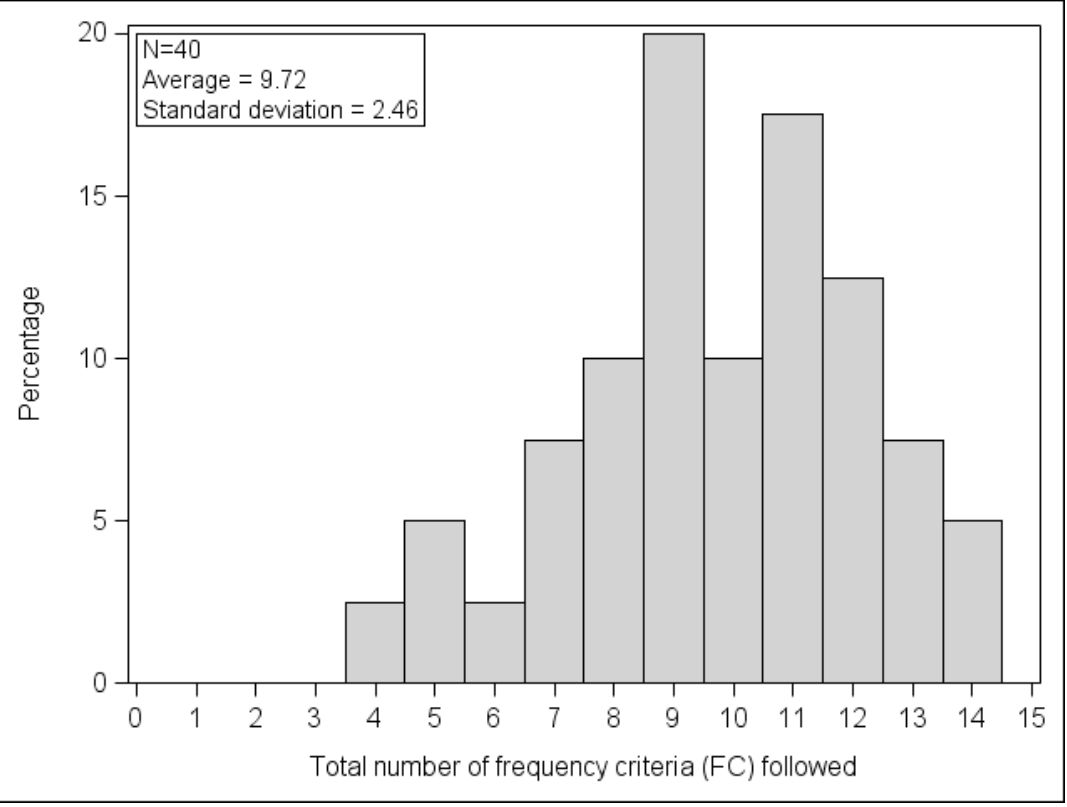
Table 2. Recommended daily intakes of energy and nutrients (proteins, essential fatty acids (FAs), fiber, vitamins and minerals) included in the calculation of the Mean Adequacy Ratio (MAR) and percentages of these recommendations in the observed series of 20 meals ( N = 40), expressed per meal a . Recommended Daily